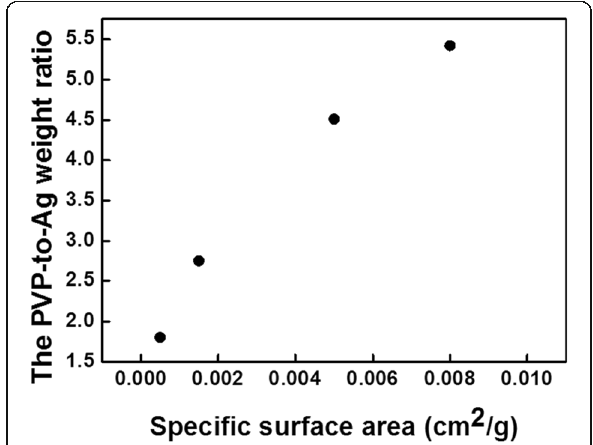
Fig. 4 The relationship between the specific area of Ag NPs in different sizes (S1 to S4) and the PVP-to-Ag weight ratio